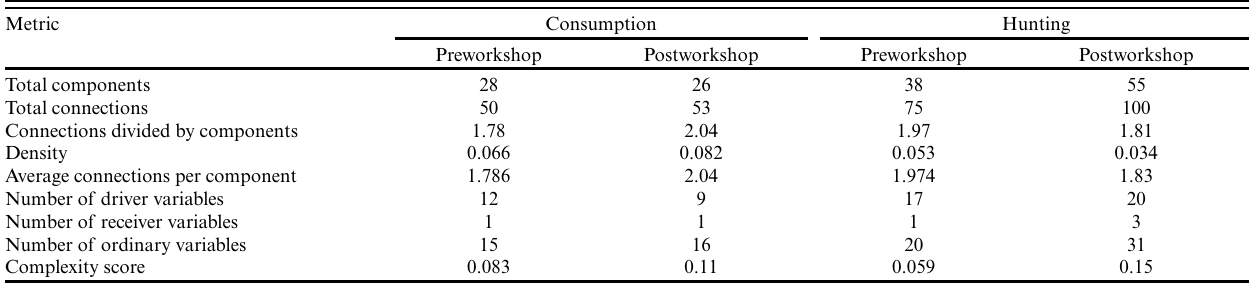
Table 3 . Comparison of metrics for group fuzzy cognitive maps generated from individual questionnaires (preworkshop) and following a participatory workshop, for bushmeat consumption and hunting in